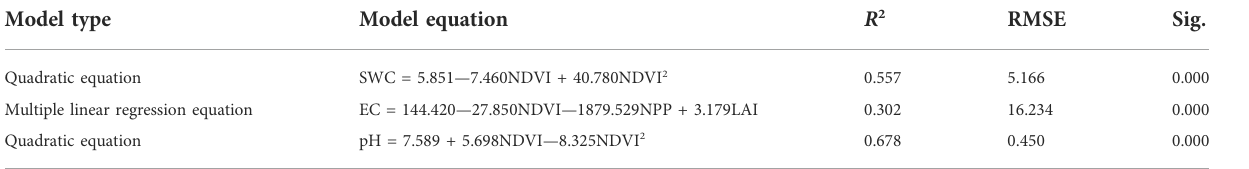
TABLE 4 Optimal model of the soil properties.